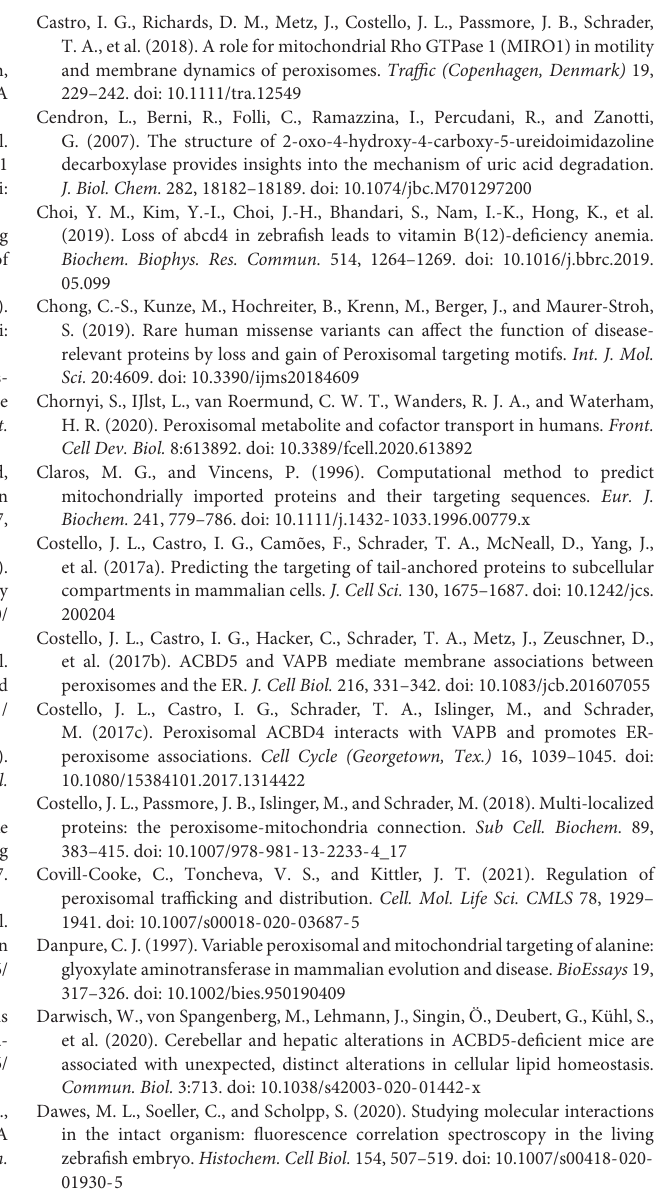
Supplementary Figure S1 | Alignment of PEX5 N-terminus and comparison between selected vertebrate species. Supplementary Figure S2 | Analysis of PTS1/PTS2 functionality for selected D. rerio candidate proteins. Supplementary Figure S3 | Differences in the PTS1-evaluation for candidate proteins. Supplementary Table S1 | Plasmids generated in this study. Supplementary Table S2 | Oligonucleotides used in this study. Supplementary Table S3 | Danio rerio theoretical peroxisomal protein